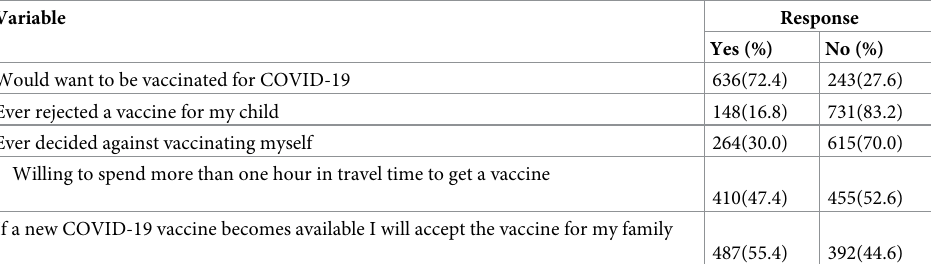
Table 3. Willingness of respondents to accept COVID- 19 vaccine.